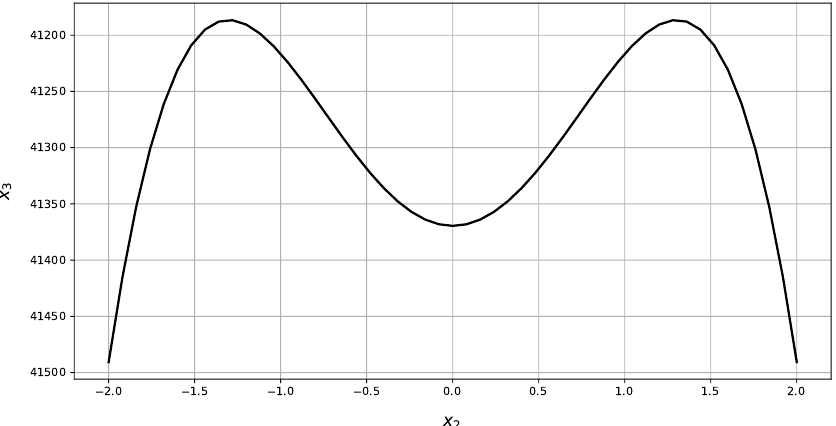
Figure 10. The bending moments M 11 in section x 1 = 0 of a rectangular plate with two opposite edges simply supported and the other free.